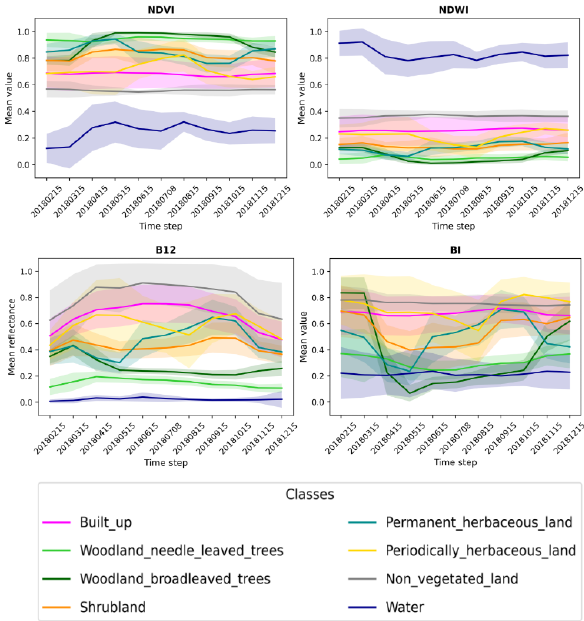
Figure 7. Class separability over time shown for three spectral indices and band B12. Intra-class variability computed using class standard deviations is represented in colored areas around each